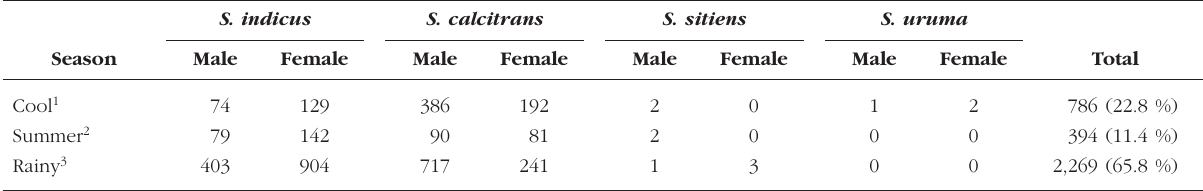
Table II. – Total number of Stomoxyine flies ( Stomoxys spp.) captured per season with Vavoua traps (64 day-traps per season) at Wang Nam Khiao District, Nakhon Ratchasima Province, Thailand.